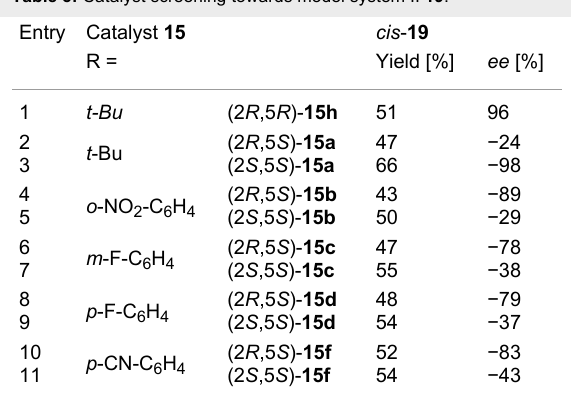
Table 5: Catalyst screening towards model system II 19